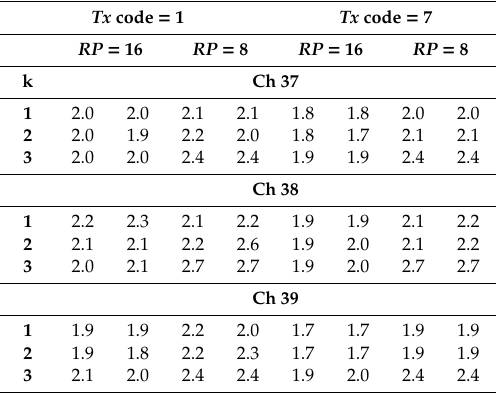
Table 29. Accuracy (in m) for Tests #11. For each number of RP, the first and second data columns refer to the iBeacon and Eddystone protocol respectively. The three advertising channels are referred to as Ch 37, etc., and the number of neighbors in the WKNN algorithm, as k